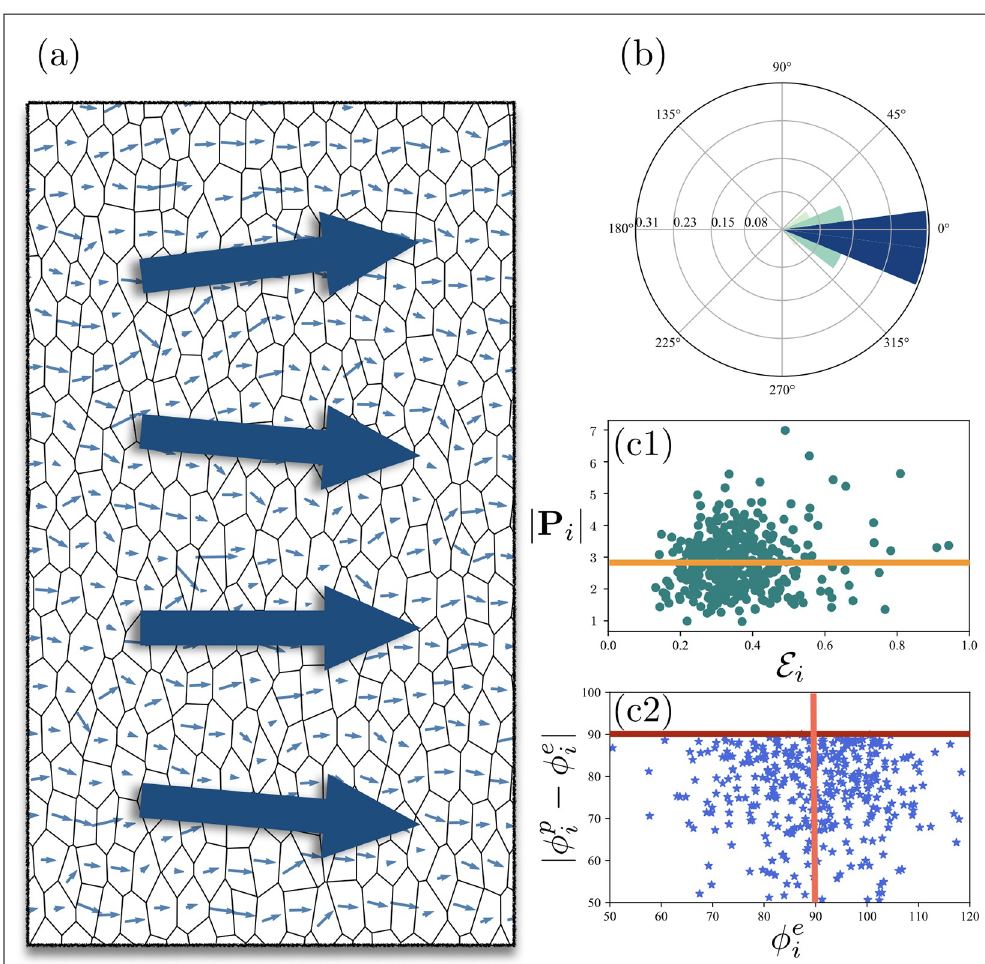
Fig 5. (a) and (b) represent the final configuration and angular distribution of polarization in an elongated tissue with E ¼ 0 : 4 . Cell-by-cell magnitudes of the dipoles | P i | versus the magnitudes of elongations E The orange line marks the mean magnitude of the cell polarities, � Q . In (c2) the relative angles of the cell dipoles and elongations j � p (cid:0) � e j , are plotted against the angles of the cell elongations. The average angle of elongation, marked by the i i vertical red line, is 90˚ with respect to the x -axis. By definition, the relative angles j � p